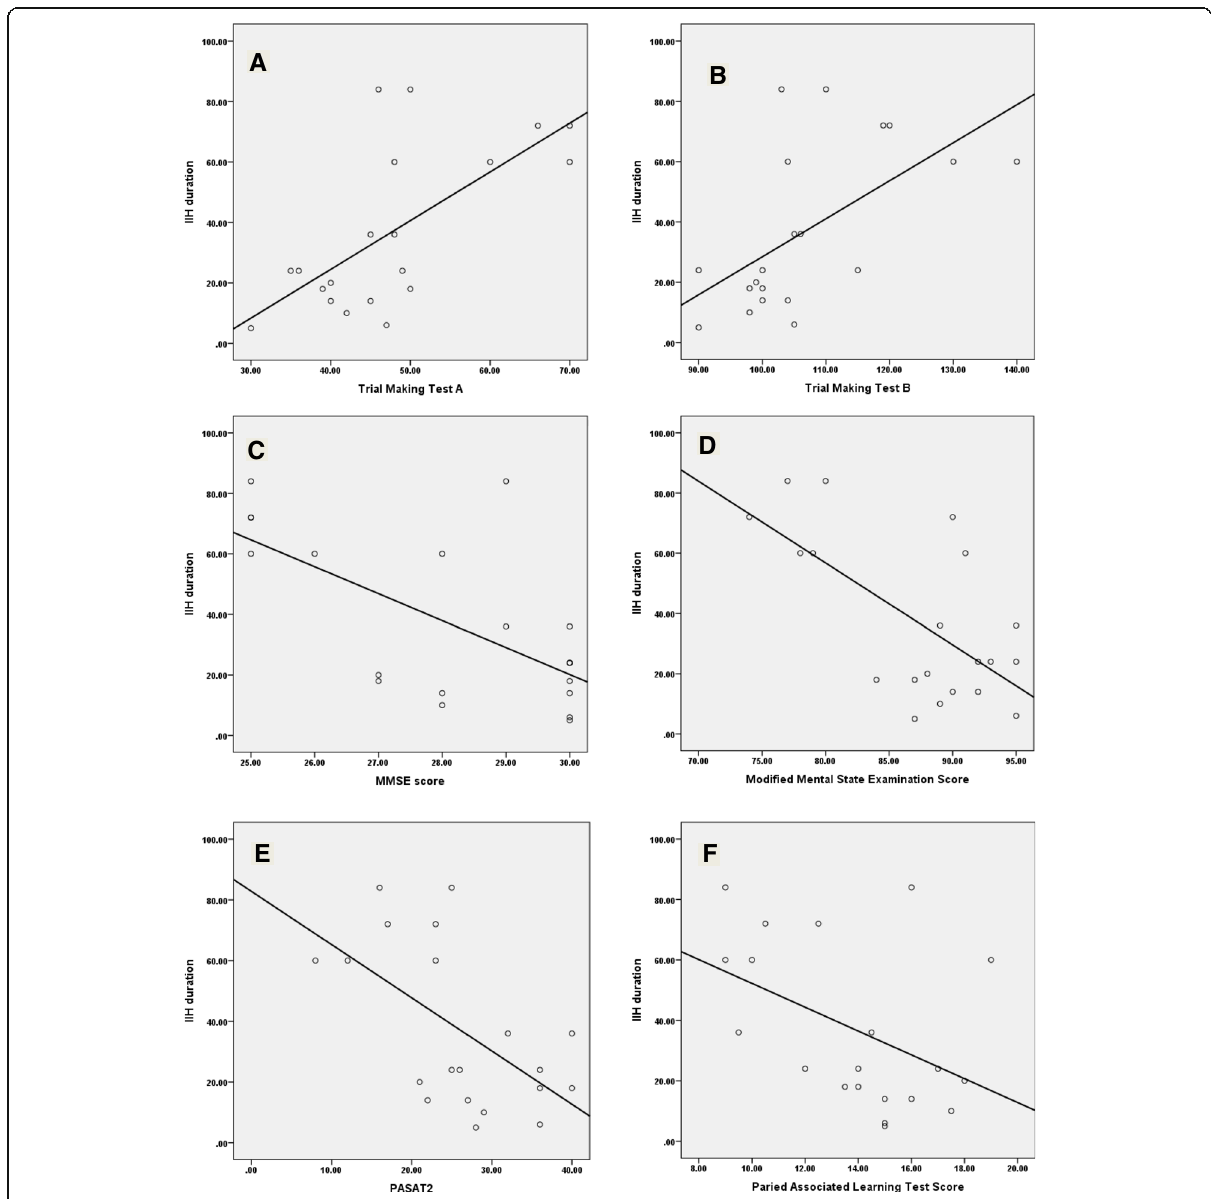
Fig. 1 Correlation between IIH duration and different psychometric tests. a Represents the correlation between IIH duration and Trail making test A (TMT A). b Represents the correlation between IIH duration and Trail making test B (TMT B). c Illustrates the correlation between IIH duration and Mini mental state examination (MMSE). d Illustrates the correlation between IIH duration and Modified mental state examination. e Represents the correlation between IIH duration and Passed auditory serial addition test 2 (PASAT 2). f Illustrates the correlation between IIH duration and Paired Associate Learning Test